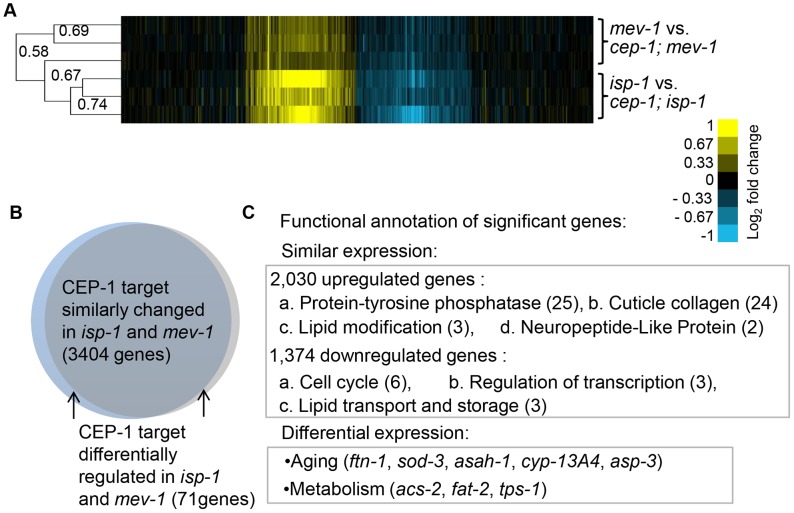
CEP-1-regulated transcriptomes in isp-1 and mev-1 mutants.(A) CEP-1-regulated genes in isp-1 and mev-1 mutants are largely similar. Hierarchical single linkage gene clustering was performed, and the dendrogram shows the clustered relationship of individual arrays. The numbers on the dendrogram represent the correlation coefficients between arrays. Yellow: upregulated, Blue: downregulated, Black: no change. (B) The expression of CEP-1-regulated genes that were significantly changed in isp-1 and mev-1 mutants, identified by SAM analysis, are represented in the Venn diagram. (C) DAVID functional annotation of similarly and differentially expressed CEP-1-regulated genes in isp-1 and mev-1 mutants. The numbers represent the enrichment scores for each group (score>1.3 is considered as significant). Several examples of aging and metabolic genes are listed.